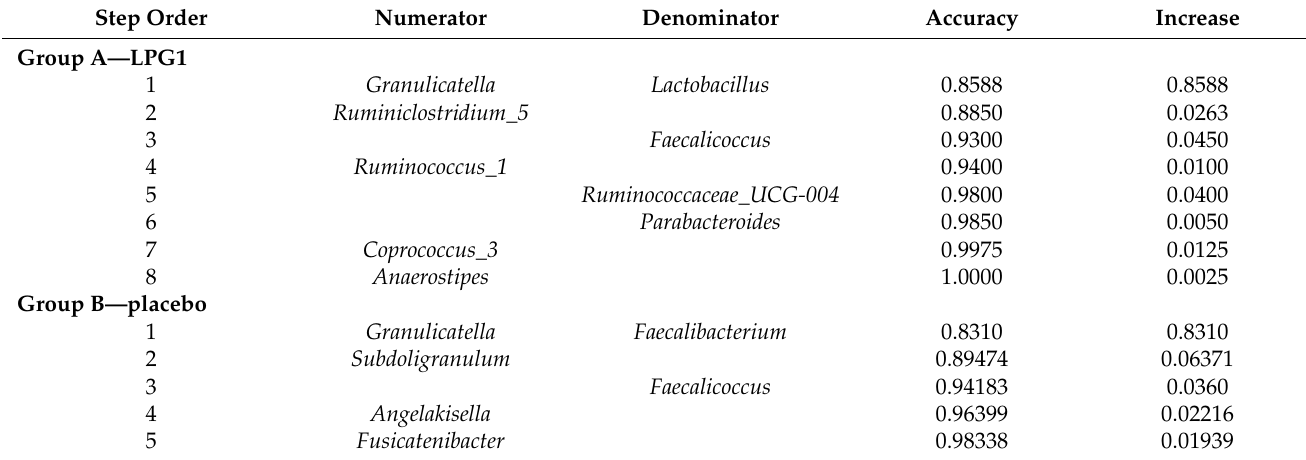
Table 3. Results of applying the selbal R package to the metataxonomic data obtained in the ran- domised, placebo-controlled, single-blind trial to study the effect of oral intake of L. pentosus LPG1 on the human gut microbiota. The table shows differentiation between the human gut microbiota composition at the initial (I) and final phases of the trial in the A-LPG1 and B-placebo groups, using a CoDA balance (signature). The table includes the ASVs selected for the balance, their assignation to the numerator or denominator, and the accuracy and its increment after each selection